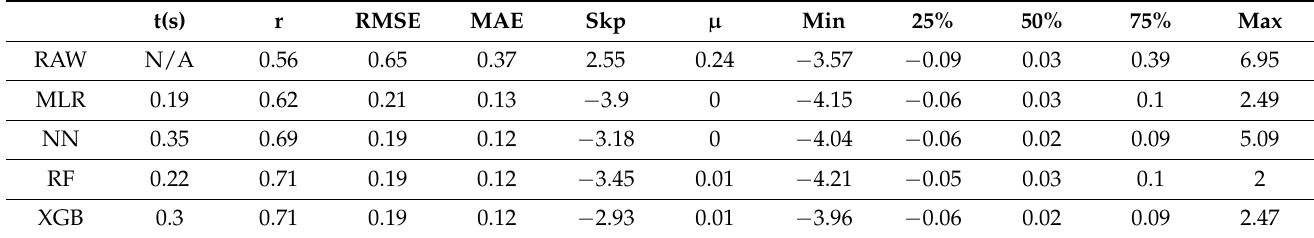
Table 1. Average performance of each AOD bias corrector and raw CHIMERE on D Test with respect to MODIS AOD. t: daily mean inference time cost; r: Pearson correlation coefficient; RMSE: root mean squared error; MAE: mean absolute error; Skp: Pearson’s coefficient of skewness; and µ : mean; percentages show the percentiles of the error. The metrics are calculated for the 737,129 pixels making D Test